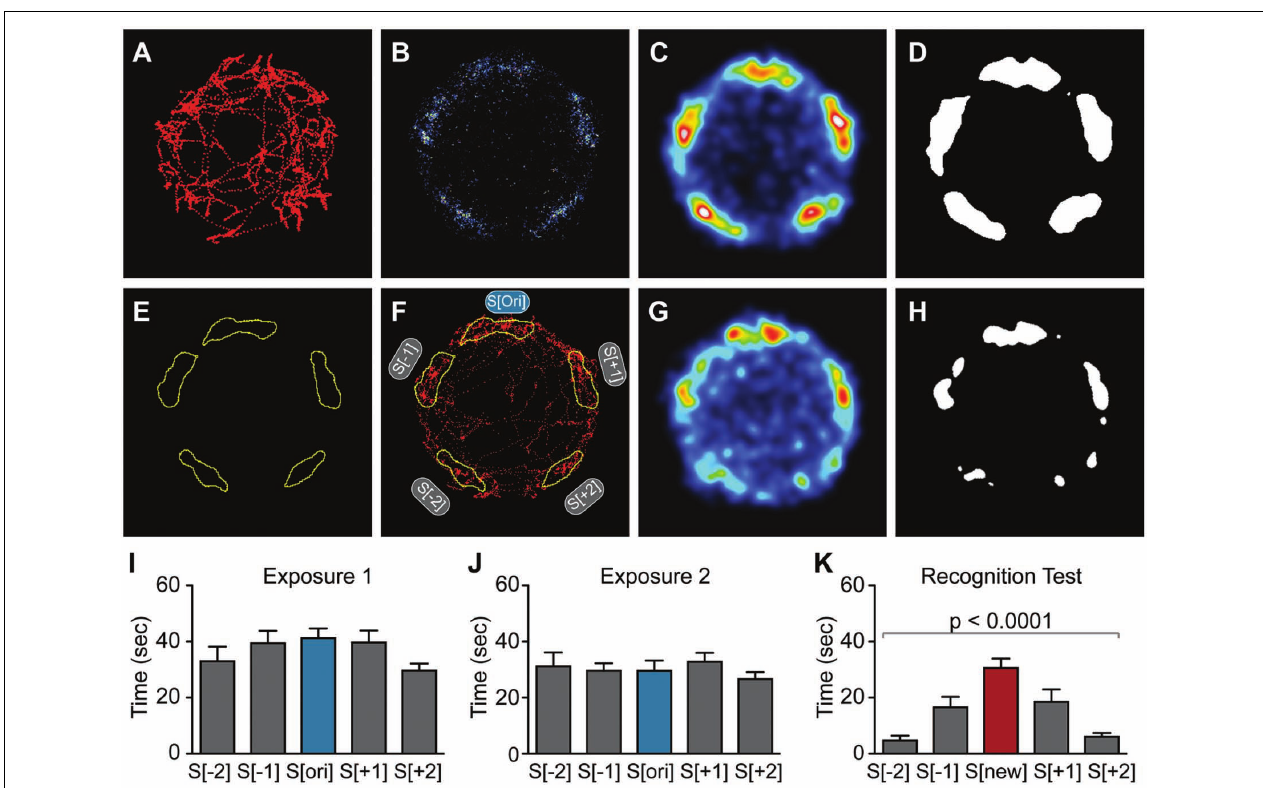
FIGURE 4 | Spatial heat map analysis improves sensitivity of detection in the SocioBox paradigm. (A–C) Generation of the spatial heat map, using data for C57BL/6J males (exposure 1, corresponds to Figure 2A ) as an example: (A) Example of body coordinates of a single mouse, exported from the Viewer3 software into FIJI. (B) Overlay of tracks from all C57BL/6J male mice for exposure 1. (C) Gaussian-weighted noise reduction filtering of the overlaid tracks to generate a spatial heat map. (D) Binary image created by application of a threshold to the spatial heat map. (E) Example of ROIs created from a binary image. (F) Example of the application of the mask created from the ROIs to the track of a single mouse. (G,H) Spatial heat map of data from the C57BL/6J male recognition test (corresponds to Figure 2C ). (G) Heat map showing the combined location of the experimental mice during the recognition test, and (H) thresholded image.